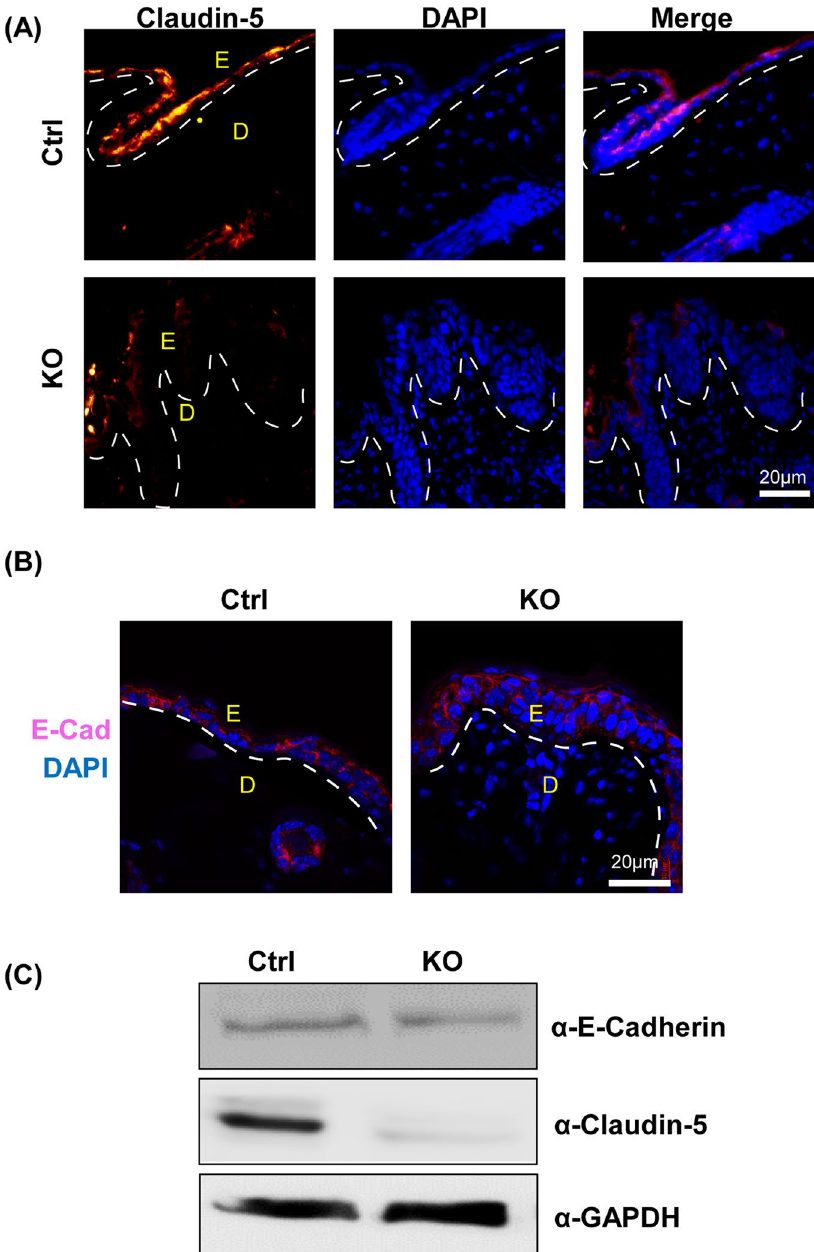
Figure 5. Expression of tight junction protein Claudin-5 is reduced in N-WASP K14KO mice. Immunostaining of Claudin-5 (A) (n = 3) and E-cadherin (B) (n = 3) in N-WASP K14KO and control mice skin showed reduced localization of Claudin-5 in N-WASP K14KO but no significant change in E-cadherin localization. (C) Western blot analysis showed reduced Claudin-5 expression but no significant reduction in E-cadherin expression in N-WASP K14KO compared to control mice skin (n = 3) (Blots were cropped and full length western blot images are in supplementary Fig.